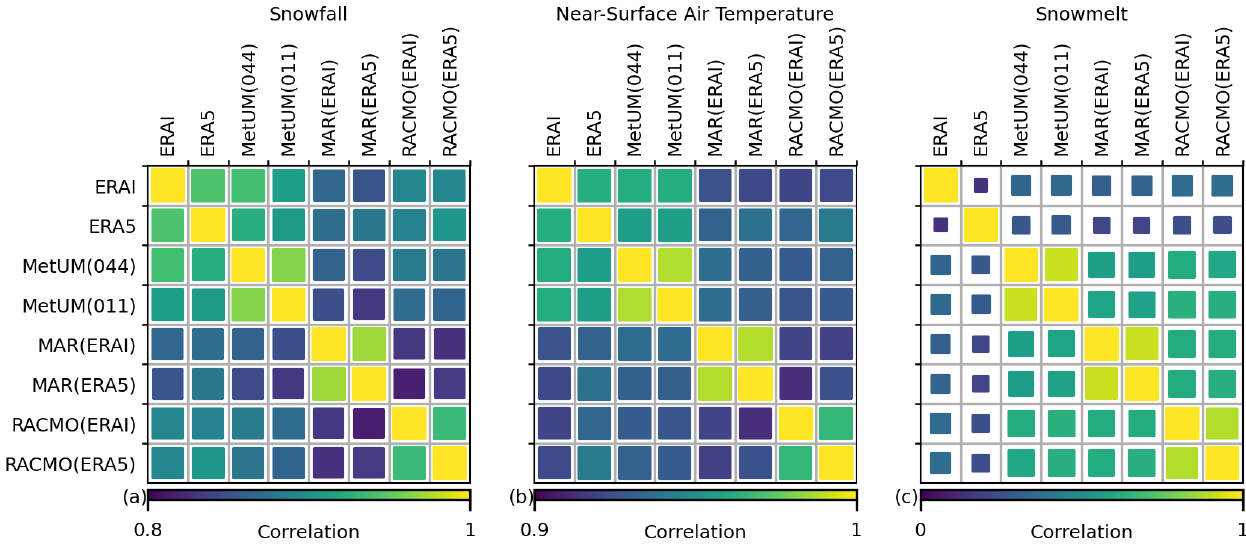
Figure 2. The correlation for snowfall (a) , near-surface air temperature (b) and melt (c) between models averaged over the ice sheet. The colour scale relates to the value of correlation, and the scale is adjusted for each plot. The size of each square also relates to the value of correlation, although it is kept constant across the figures, going from 0–1, to make comparisons clear between the different variables.